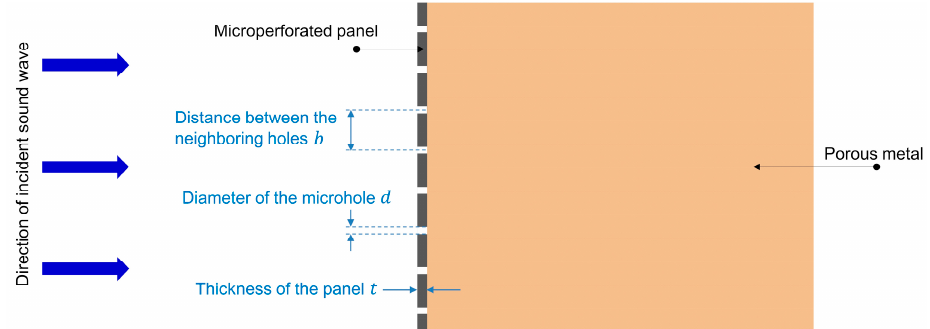
Figure 7. Sound absorption coefficients of the porous metal with a thickness of 35 mm.